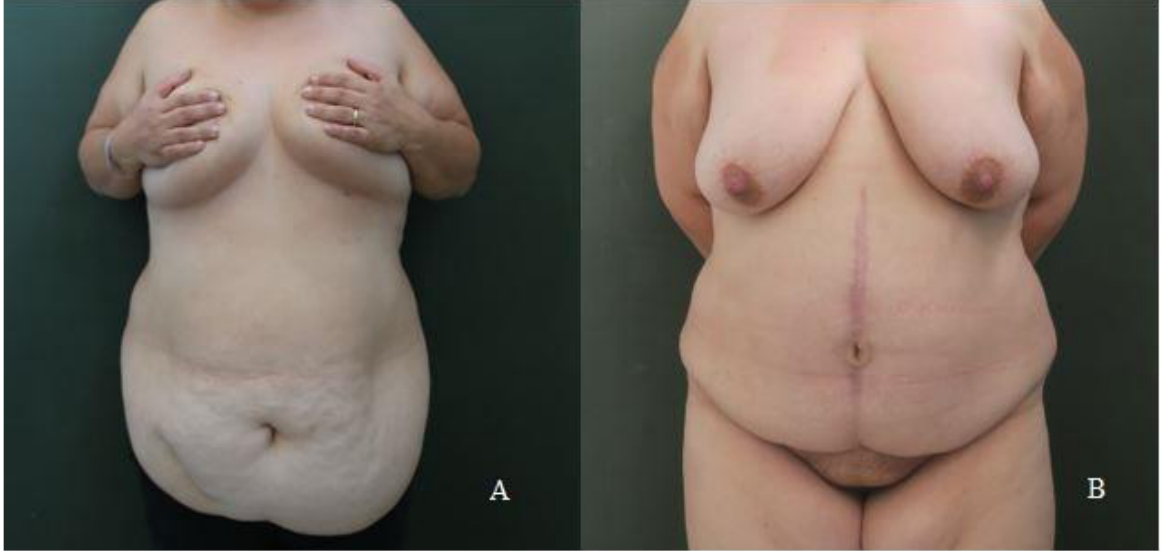
Figure 5. ( A ) A preoperative photo of a patient undergoing vertical abdominoplasty with preservation of the native umbilicus. ( B ) The same patient 12 months after surgery.